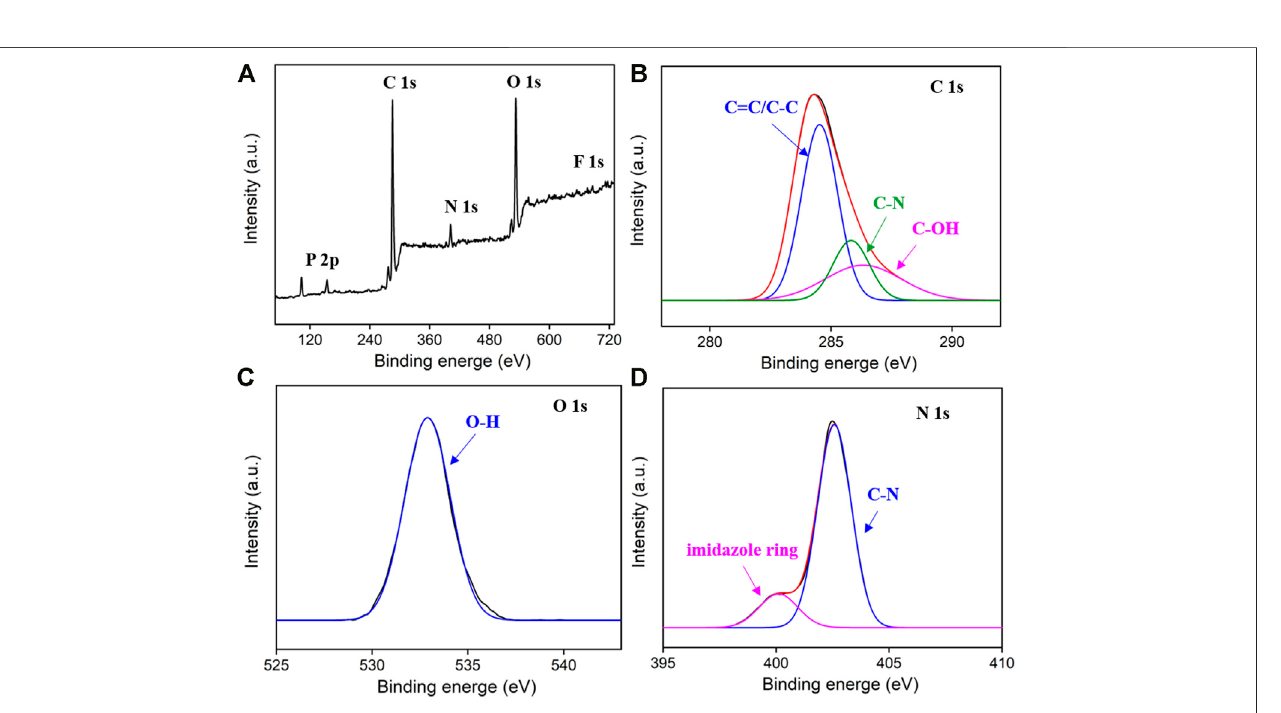
Frontiers in Chemistry |